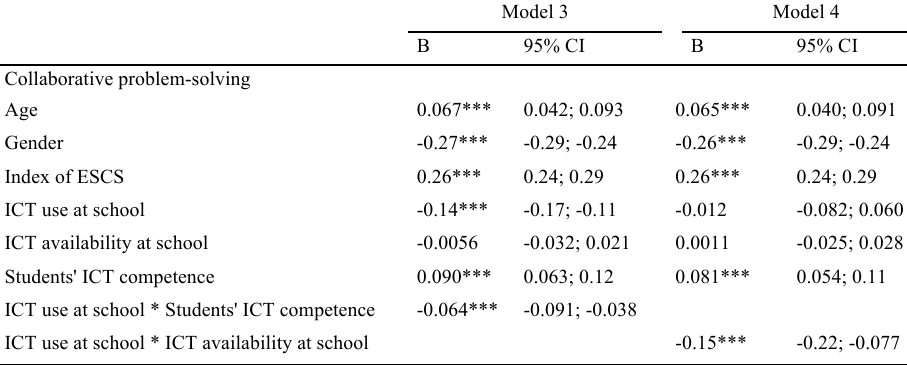
The standardized coefficients (B) with 95% confidence intervals of the ICT variables, when predicting students’ learning outcomes with structural equation